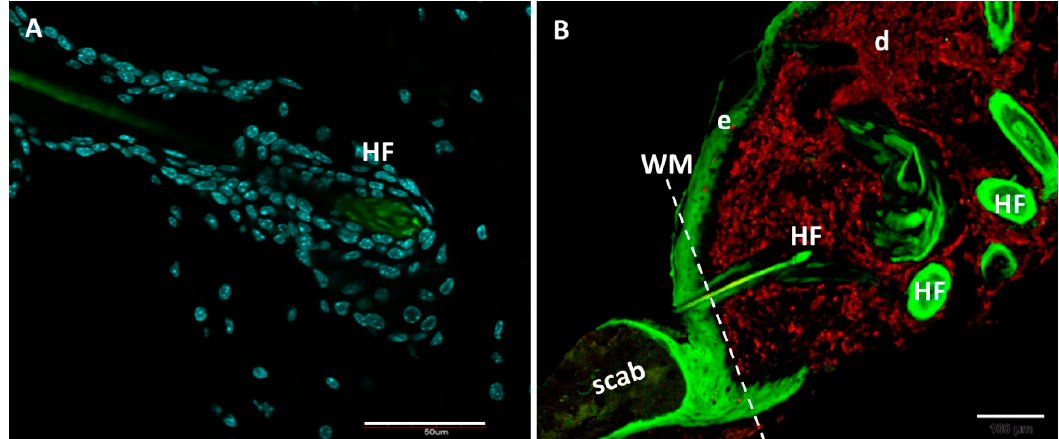
Figure 1. Histological analysis of skin sections collected from transgenic Foxn1::Egfp mice. ( A ) Confocal microscopy imaging of Foxn1/eGFP localisation in hair follicle (nuclei were counterstained with DAPI); ( B ) Fluorescent localisation of eGFP (green) and immunofluorescent detection of vimentin (red) in postwounded skin tissues. Foxn1-positive cells accumulated in the post-wounded skin area and in the leading epithelial tongue migrating underneath the scab. Abbreviations: WM—wound margin, HF—hair follicle, e—epidermis, d—dermis. Scale bar 50 µm ( A ), 100 µm ( B ).